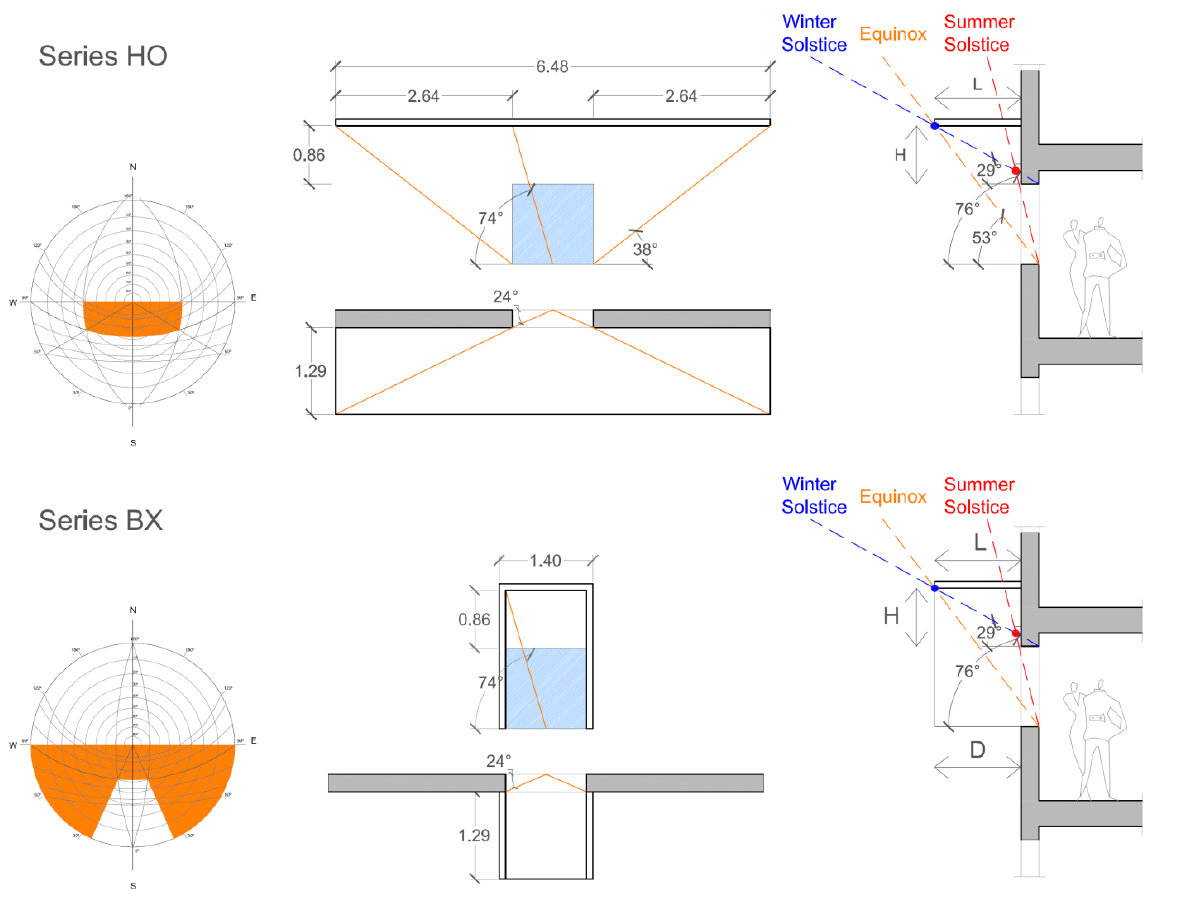
Figure 5. Determining the maximum and minimum length of the overhangs and lateral